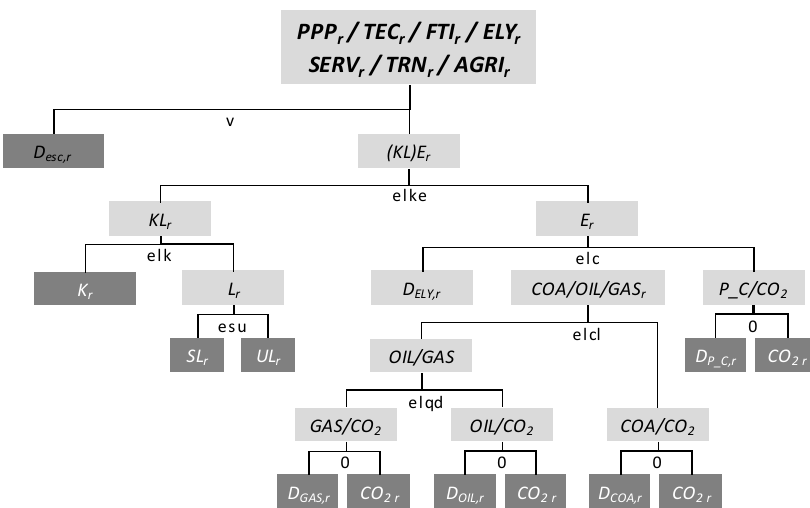
Figure A3. Nesting structure of non-resource using sectors without process emissions in production in the CGE model.